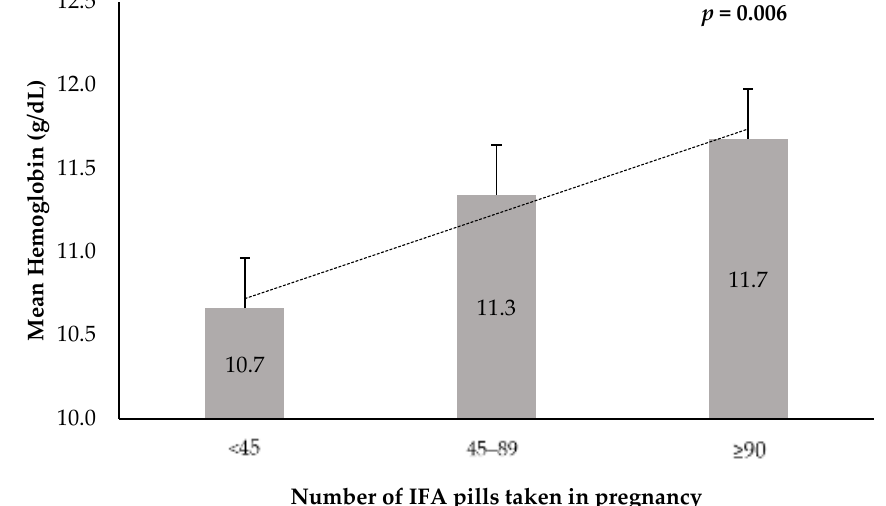
Figure 1. Mean maternal hemoglobin levels before delivery, by number of IFA pills taken during pregnancy.